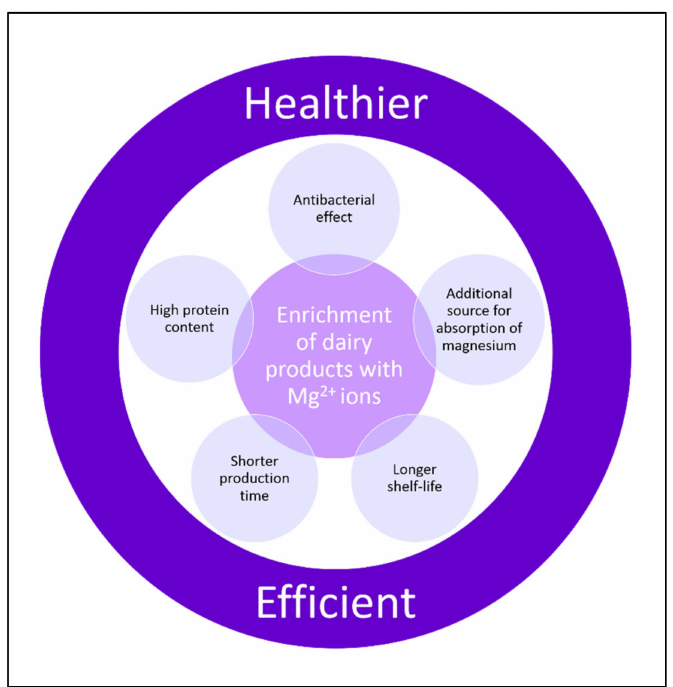
Figure 2. Enrichment of food products, for instance, dairy products, with magnesium would provide pronounced advantages and eventually result in healthier and e ffi cient food